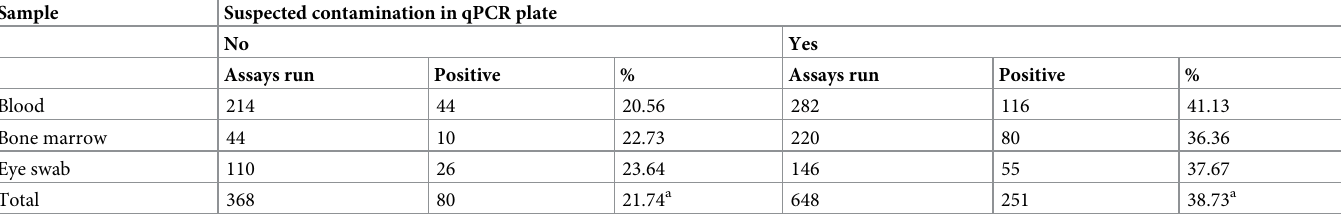
Table 7. Positivity of quantitative PCR (qPCR) assays run on samples drawn from central-western Brazilian dogs: Results stratified by biological sample and sus- pected qPCR plate contamination. Sample